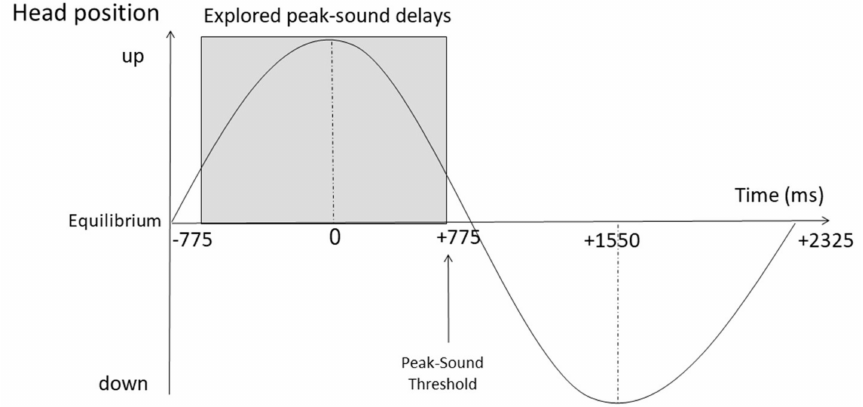
Figure 1. Relation between sound stimuli and bed oscillation. During bed oscillations a beep was generated by the electronic device with an adjustable time lag. The zero was defined as the peak of the oscillation (head at its maximal height). The time lag between the beep and the head peak was modified from − 750 ms to +750 ms with 50 ms increments. Patients were asked to indicate whether the sound and the peak are synchronous. The explored interval is depicted in gray. The upper border was measured and defined as the peak-sound